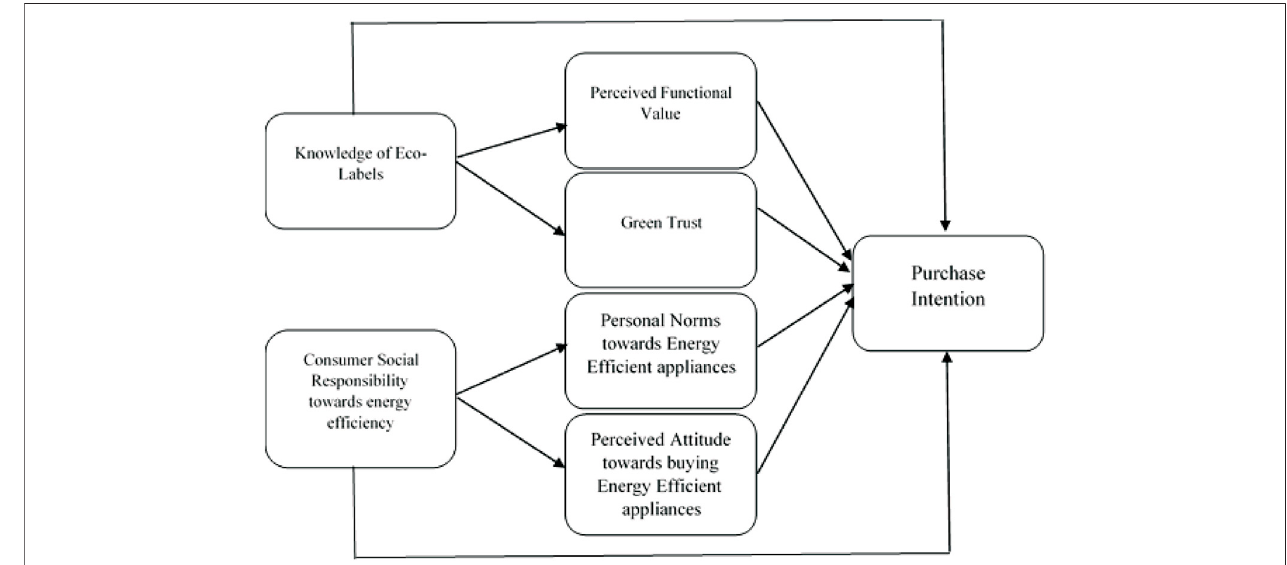
FIGURE 1 | Conceptual